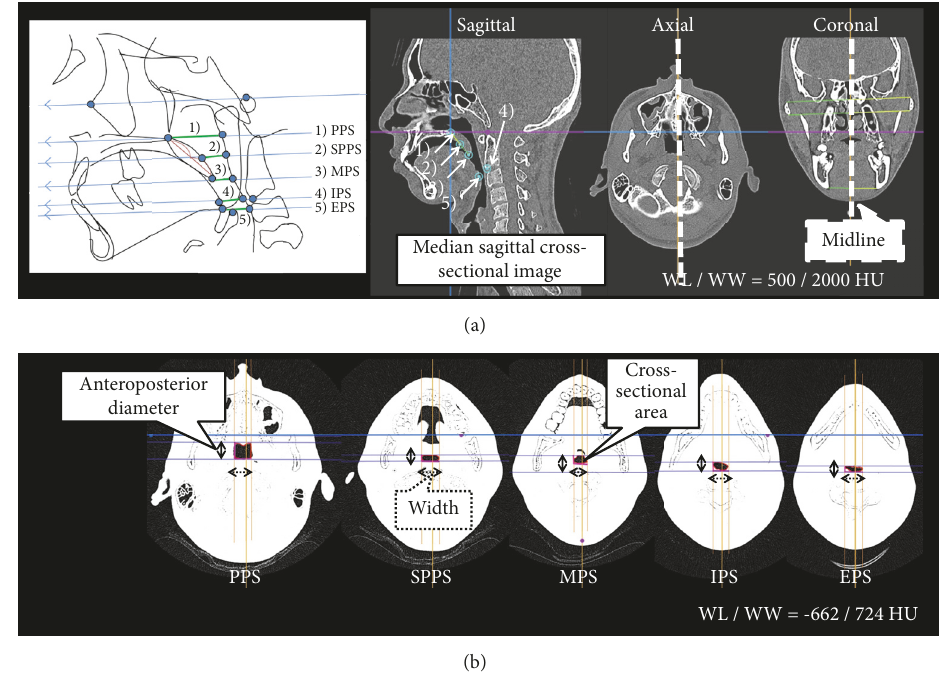
Figure 2: The measurement variables. (a) Midline and median sagittal cross-sectional images. (b) The five measurement sites of the upper airway on a multiplanar reconstruction (MPR) image. The multislice computed tomography data were imported into OsiriX ver. 3.9, with the window level/window width (WL/WW) set to the CT-bone value of 500/2000 HU. Slice datasets were coordinated as follows: (1) the midline of a midpoint of two straight lines, connecting the uppermost and lowermost ends of the bilateral zygomatic process observed in the coronal section, and a straight vertical line parallel to that midpoint were drawn; (2) the median sagittal cross-sectional image was a sagittal section sliced by the midline, and the median sagittal and axial cross-sections were set to the posterior edge of the maxillary bone (PNS); (3) five distance points were established on the MPR image by verifying on the median sagittal, axial, and coronal cross-sectional images; and (4) the WL/WW was set to the airway component value of -662/724 HU, and the anteroposterior diameter, width, and cross-sectional area at the five distance points were measured on the axial cross-sectional images. Abbreviations: EPS, epiglottic pharyngeal space; IPS, inferior pharyngeal space; MPS, middle pharyngeal space; PPS, palatal pharyngeal space; SPPS, superior posterior pharyngeal